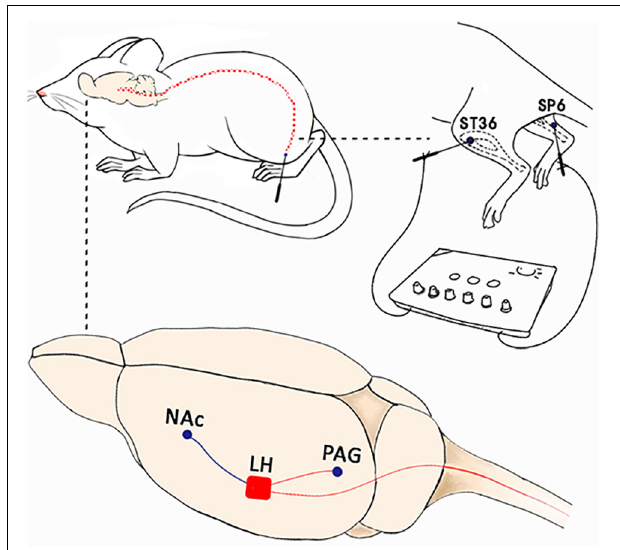
FIGURE 9 | The possible mechanism involved in orexin signals in the lateral hypothalamus for acupuncture analgesia. Acupuncture signals at various acupuncture points can travel through the spinal cord to the hypothalamus. The LH orexin system is a central hub that can integrate outputs to various brain areas that can actively participate in acupuncture or EA analgesia. The projections to orexin signals in the spinal cord and PAG (descending circuits) were involved in EA-induced pain inhibition. The orexin signals in the NAc shell were found to be involved in EA-induced reward effects and inhibition of the affective component of